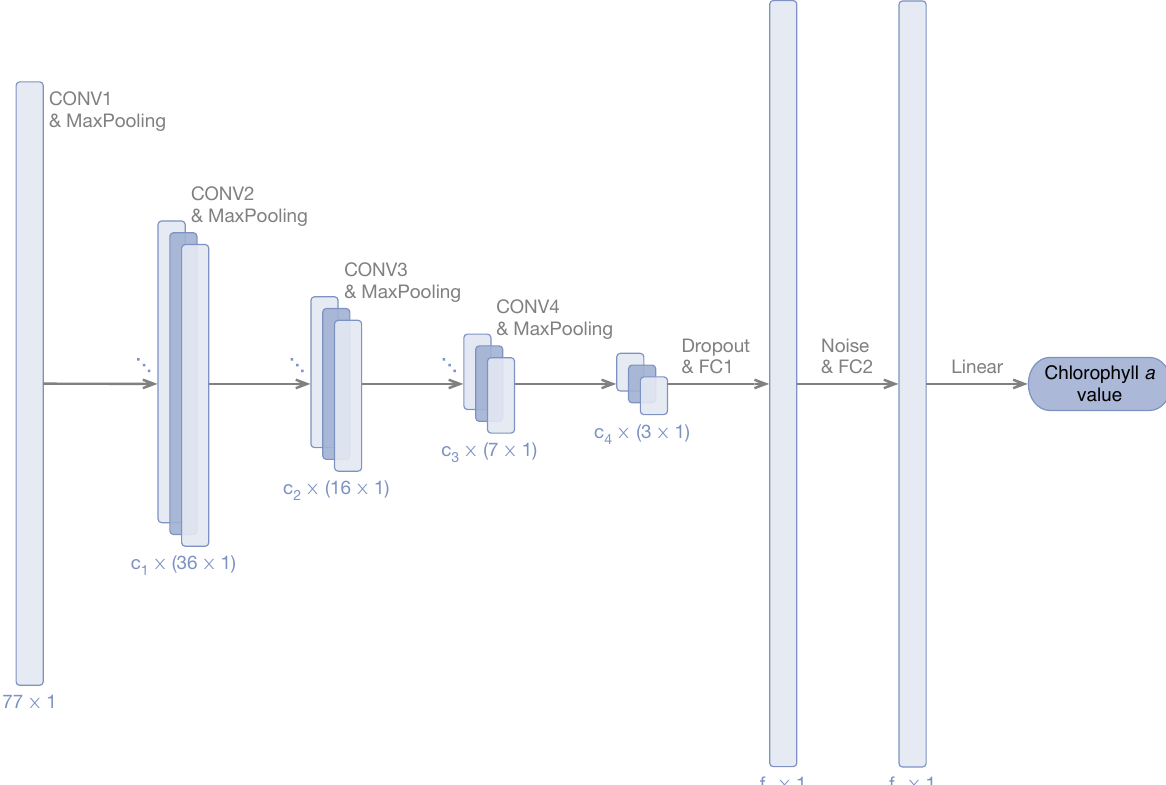
Figure 7. Flowchart of the 1D CNN for the SR-EnMAP spectral input features during the training process. The network includes convolutional (CONV), fully-connected (FC), and max-pooling (MaxPooling) layers. Besides, a layer with Gaussian noise (Noise) and a dropout layer (dropout) exist. The I -th CONV layer contains c i filters and the j -th FC layer contains f j units. At the end of the network, a linear activation function is applied. Adopted from [45]. Adapted with permission from Riese and Keller (2019). Copyright 2019 Riese and